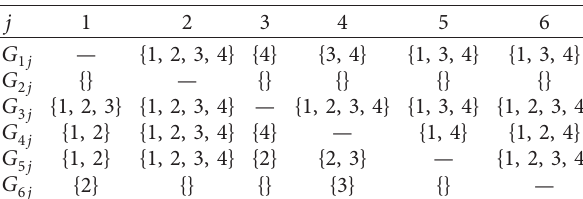
Table 5: 4F discordance